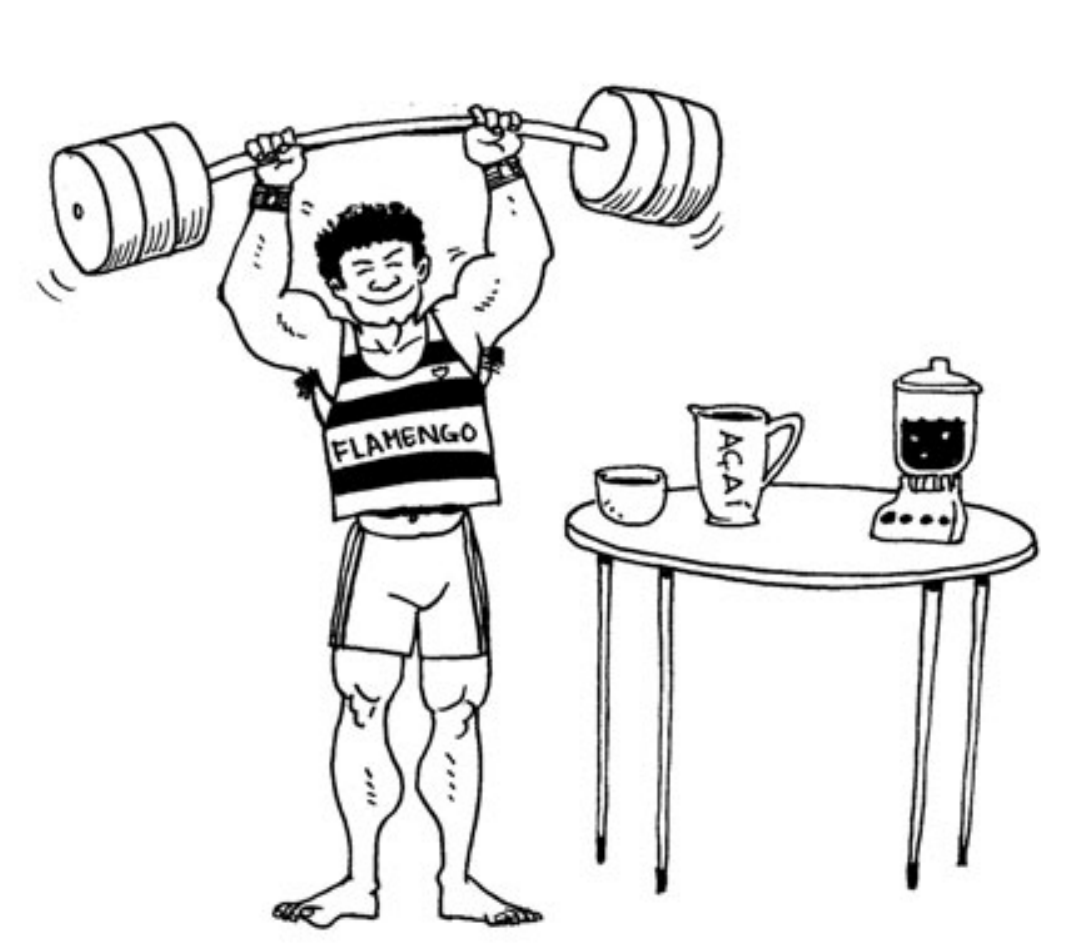
Fig. 8. Sales of Amazonian fruit juice have skyrocketed in fitness centers in São Paulo. Source: Shanley and Medina